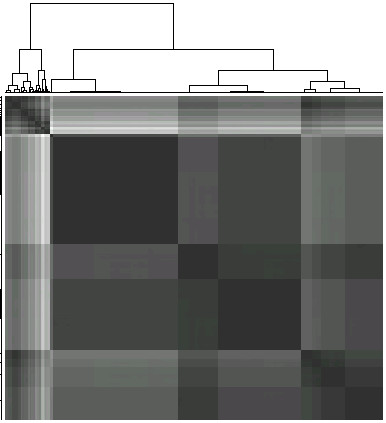
Heatmap and cluster diagram demonstrating the clustering of proteins based on their sociality parameters. Figure 1 presents the heatmap and the cluster diagram depicting groups of structurally similar proteins in the protein interaction network obtained by clustering the sociality parameters of the proteins.